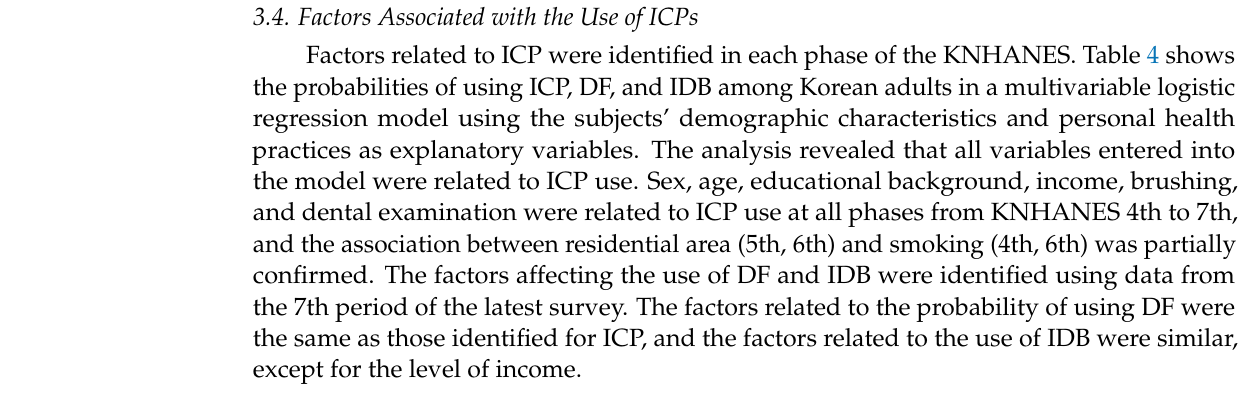
Table 4. Odds ratios and 95% confidence intervals of interdental care products use by demographic characteristics and health behaviours among adults aged 30 years or older according to KNHANES phase (2007–2018) and each product in the 7th